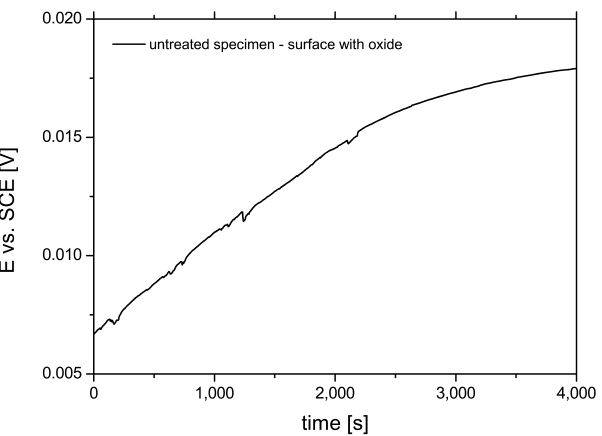
Figure 4. Evolution of corrosion potential E corr on oxidized surfaces after exposure testing in auto- clave of untreated